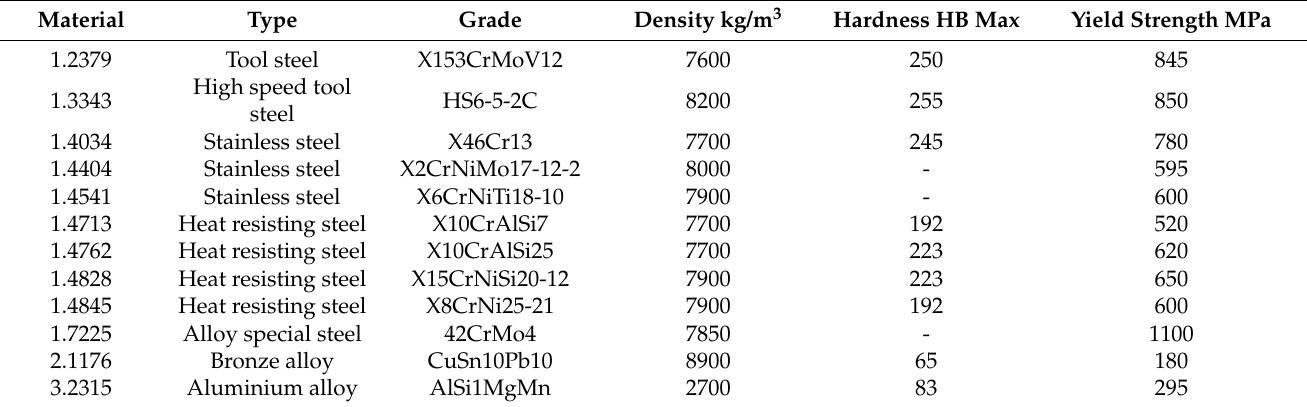
Table 1. Properties of used materials selected from the material sheets summarized in lexicon